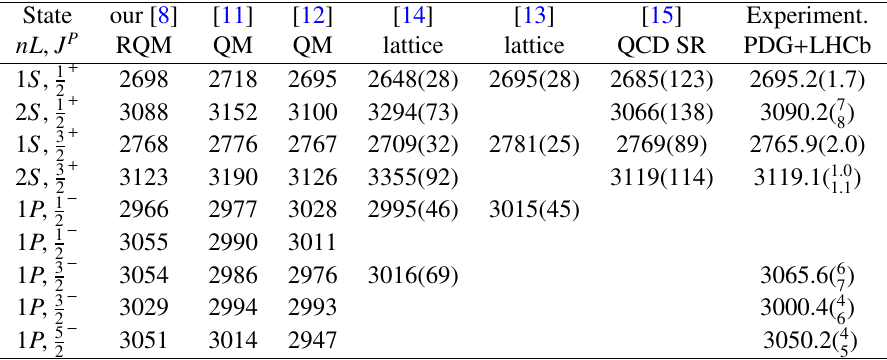
Table 6. Comparison of theoretical predictions for the masses of the Ω c